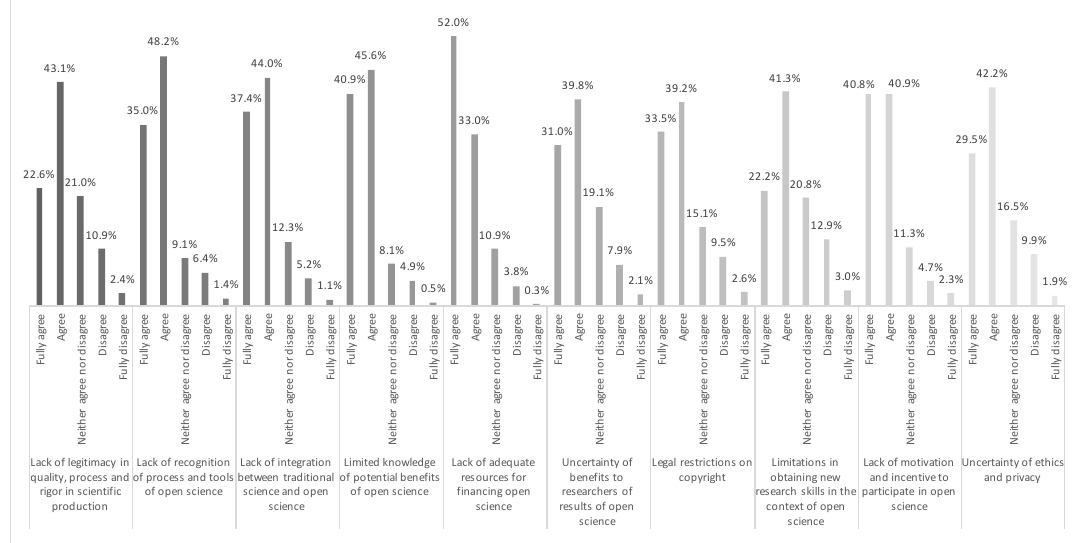
Figure A2. The main barriers to open science, according to Colombian researchers.